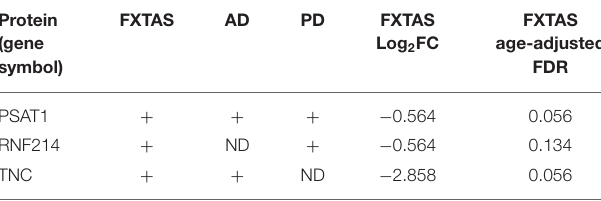
TABLE 6 | Comparison of FXTAS, PD, and AD proteomes a . Protein (gene symbol)